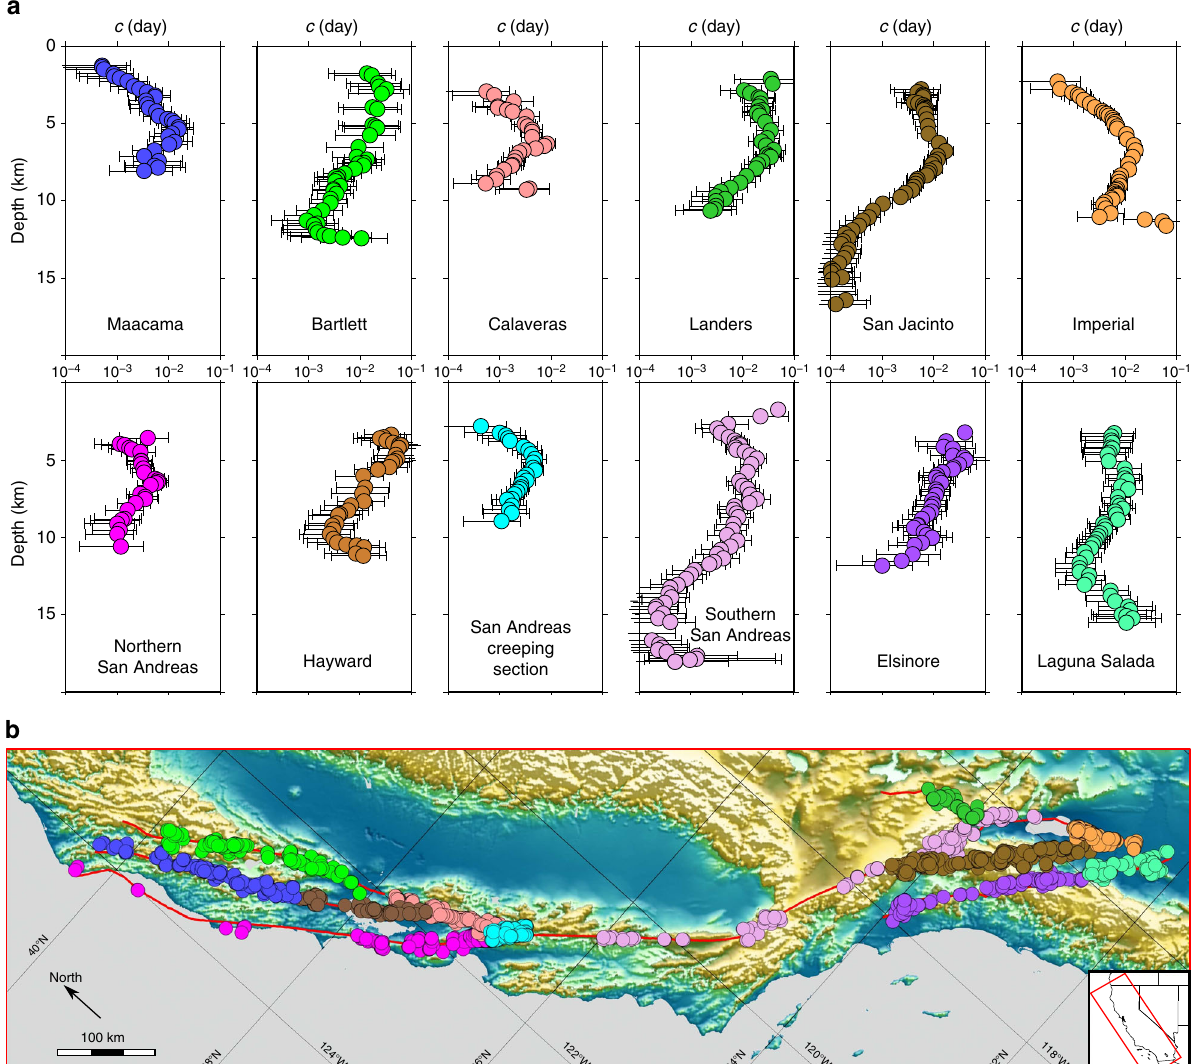
Fig. 2 In fl uence of depth on the time delay before the onset of the power-law aftershock decay rate along major strike-slip faults in California. a Logarithm of the most probable c -value for p = 1 with respect to the mean depth of the selected aftershocks within the 3 km depth bins along individual faults. Error bars show the 95% Bayesian credibility regions for the c -value. b Major strike-slip faults in California and location of the selected mainshocks (colour code as in